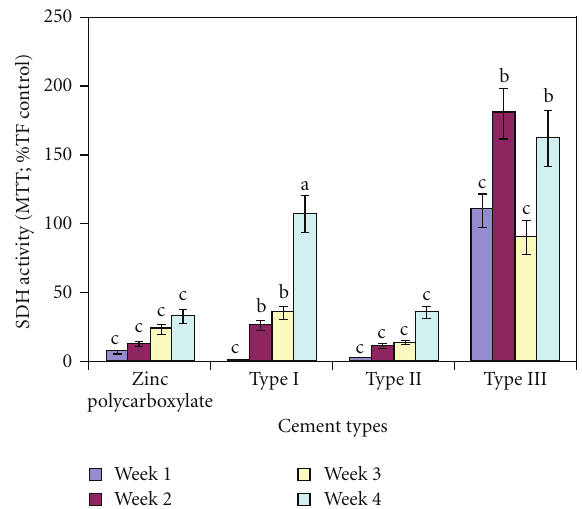
Figure 8: Mitochondrial suppression induced by zinc polycarboxy- late, Type I, Type II, and Type III calcium phosphate cements as function of aging time. Cytotoxicity was measured by succinic de- hydrogenase activity and expressed as a percentage of Teflon con- trols (defined as 100%). There were six replicates per condition. Di ff erent letters indicate a statistically significant di ff erence between the materials (ANOVA, Tukey intervals α = 0 .